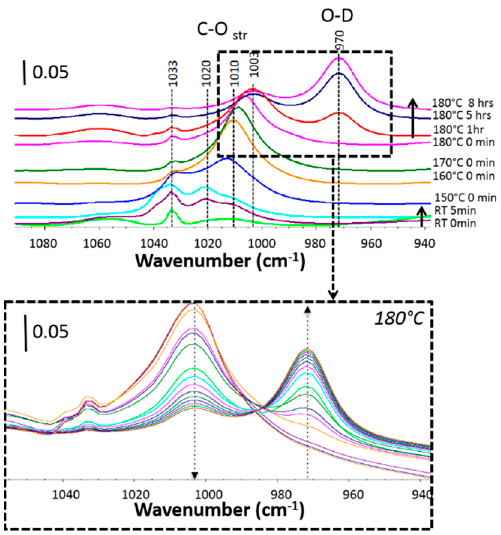
Figure 2. ( Top ) Absorbance IR absorption spectra of Zn-MOF-74 loaded with a mixture of 8 Torr methanol and 8 Torr D 2 O as a function of temperature and time. ( Bottom ) Detailed reaction evolution at 180 °C from 0 to 8 h (dashed arrows indicate the time evolution).